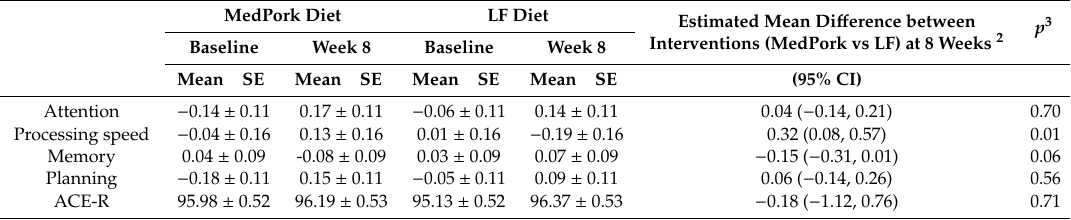
Table 3. The standardised cognitive composite scores and ACE-R at the baseline and final visit, including between group di ff erences ( n = 33) 1